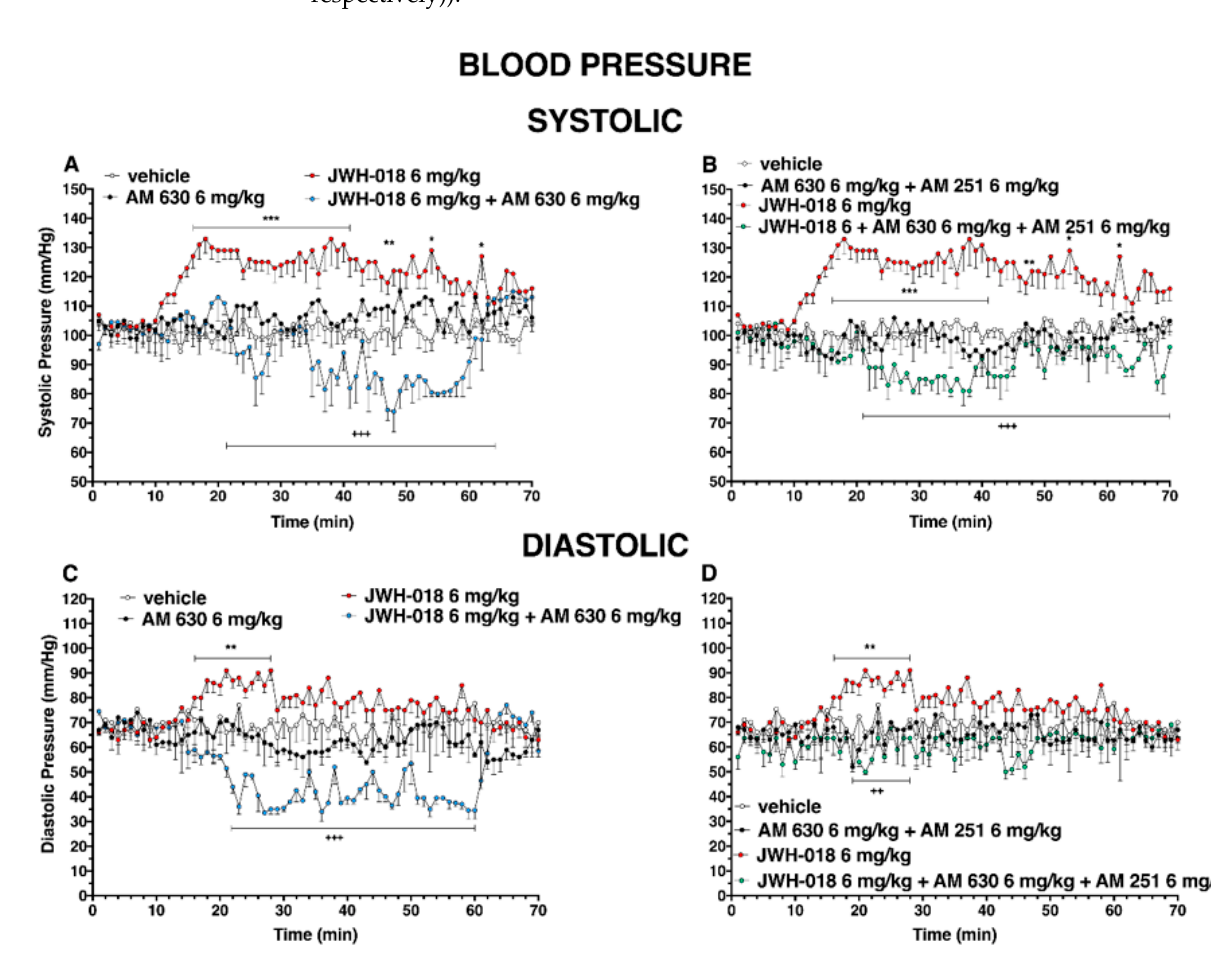
Figure 11. Interaction of JWH-018 (6 mg/kg i.p) with the selective CB 2 receptor antagonist AM 630 (6 mg/kg, i.p.) and with the administration of the mixture of the selective CB 2 receptor antagonist AM 630 (6 mg/kg) and AM 251 (6 mg/kg) on systolic (panels ( A , B ) respectively) and diastolic (panel ( C , D ), respectively) blood pressure. Statistical analysis was performed by two-way ANOVA, followed by Bonferroni’s test for multiple comparisons. * p < 0.05 ** p < 0.01 *** p < 0.001 versus vehicle and ++ p < 0.01, +++ p < 0.001 versus AM 630 + agonists or AM 630 and AM 251 + agonists.